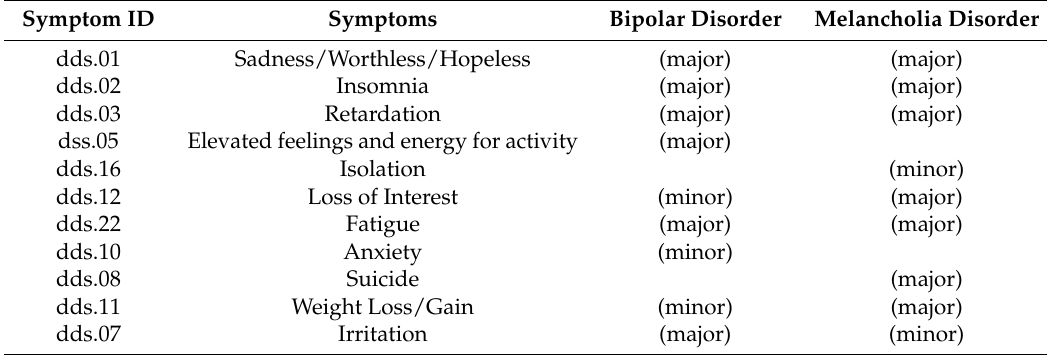
Table 2. Depressive Disorder Symptoms for Bipolar and Melancholia disorder. The dds keyword in